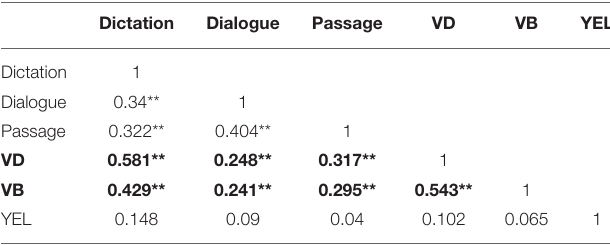
TABLE 6 | Correlations between both vocabulary knowledge and three listening measures and years of English learning.